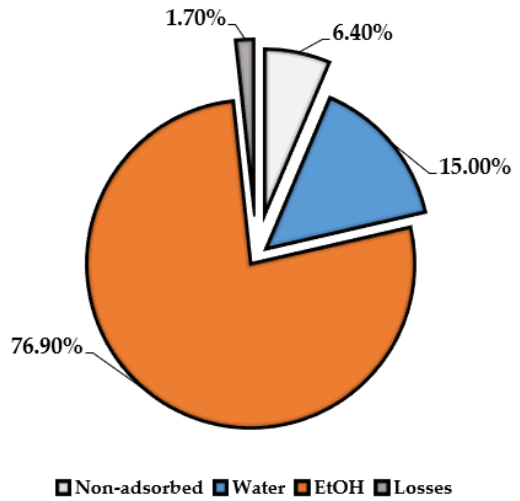
Figure 12. TPC recovery trend, depending on the different elution fractions.